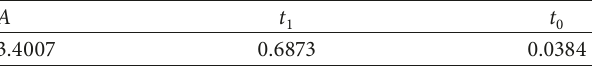
Table 9: Parameters for improving tangential Poisson’s ratio in the Et- ] t